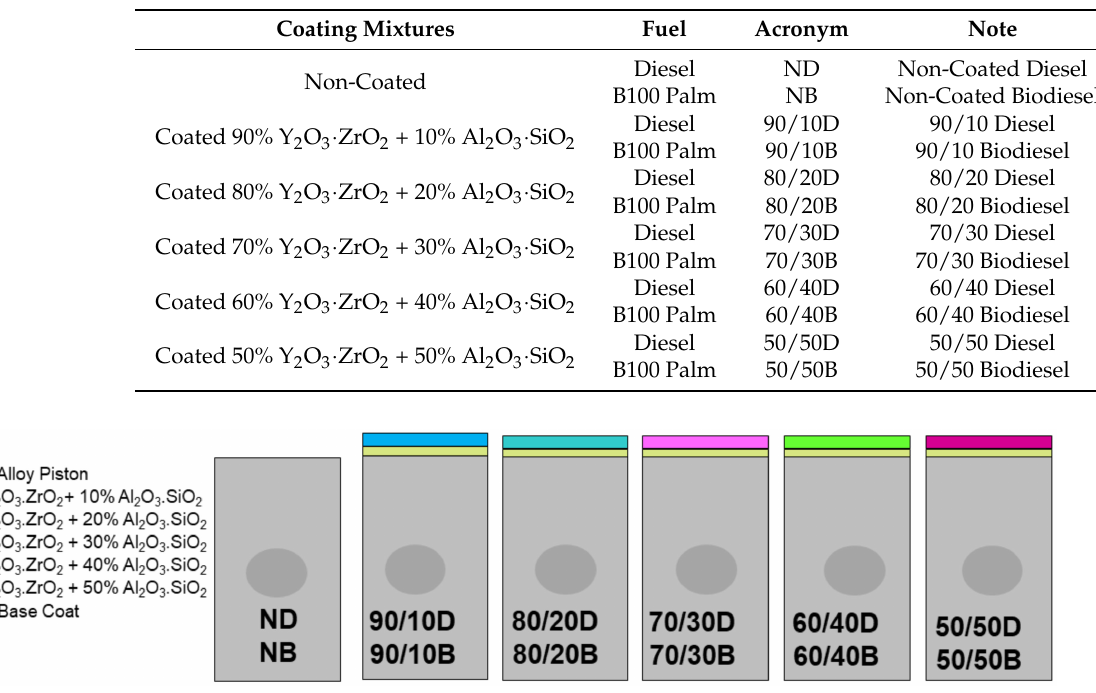
Figure 4. Piston crown configuration with specific coating mixture. Table 4. List of physical and chemical properties of biodiesel and diesel